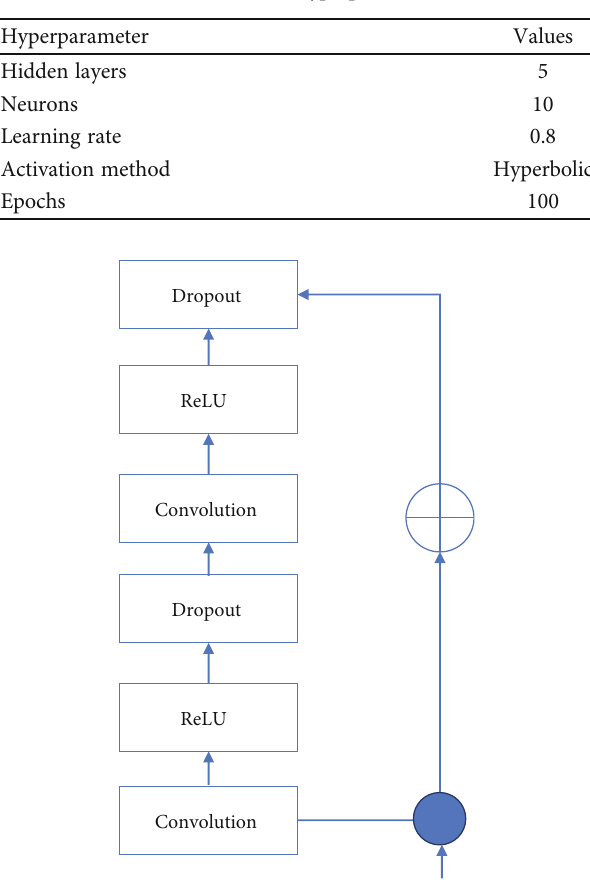
Table 1: ResNet hyperparameters.